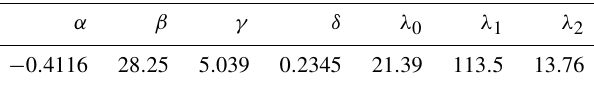
Table 4. Best fit correction function parameters as determined by applying the correction to every second